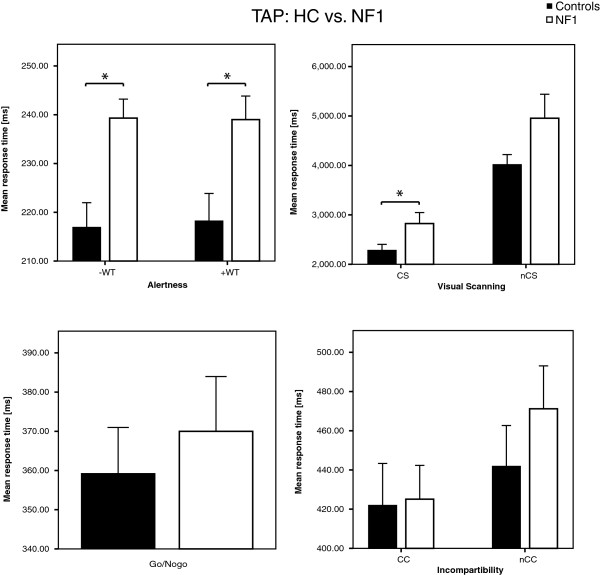
Reaction times of TAP in healthy controls and patients with NF1. Data of 10 patients with NF1 and healthy controls are plotted for Alertness, Go/NoGo, Visual Scanning and Incompatibility. Here patients with NF1 (treated with placebo but not with lovastatin) scored in lower ranges than healthy controls. The significance was set at a level of p < 0.05 and error bars represent ± standard error of the mean. Alertness: –WT (without warning tone), +WT (with warning tone); Visual Scanning: CS (critical stimulus), nCS (non critical stimulus); Incompartibility: CC (critical condition), nCC (non critical condition).